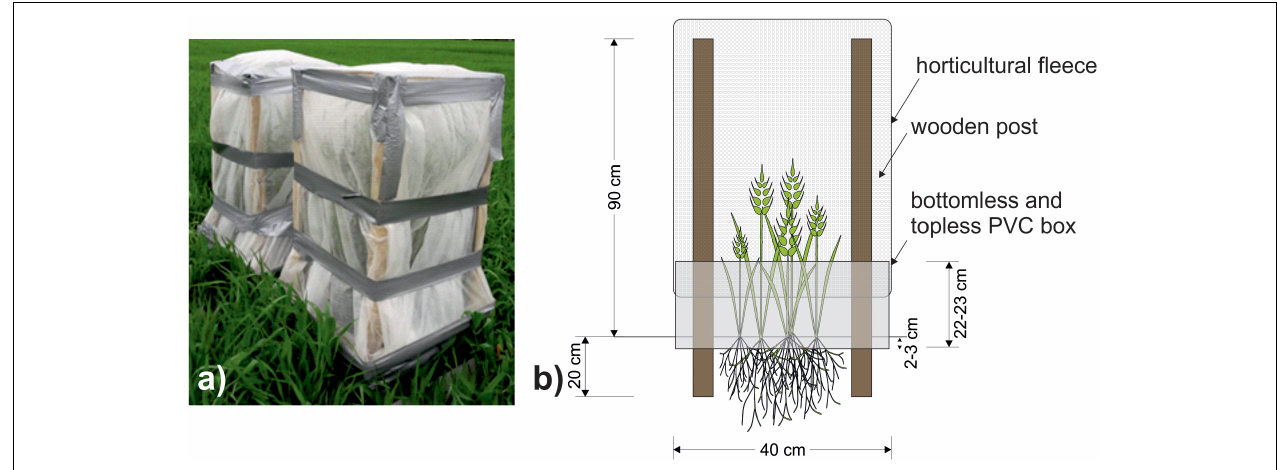
FIGURE 2 | (a) Photograph of a pair of completed aphid cages covering plots taken on 17th May 2017. (b) Schematic of cage design used to prevent aphid movement between the plots. Wooden posts reaching 90 cm high were inserted 20 cm into the ground to support a cage of polypropylene horticultural fleece sealed to a 40 cm × 40 cm PVC box reaching 22–23 cm above ground.